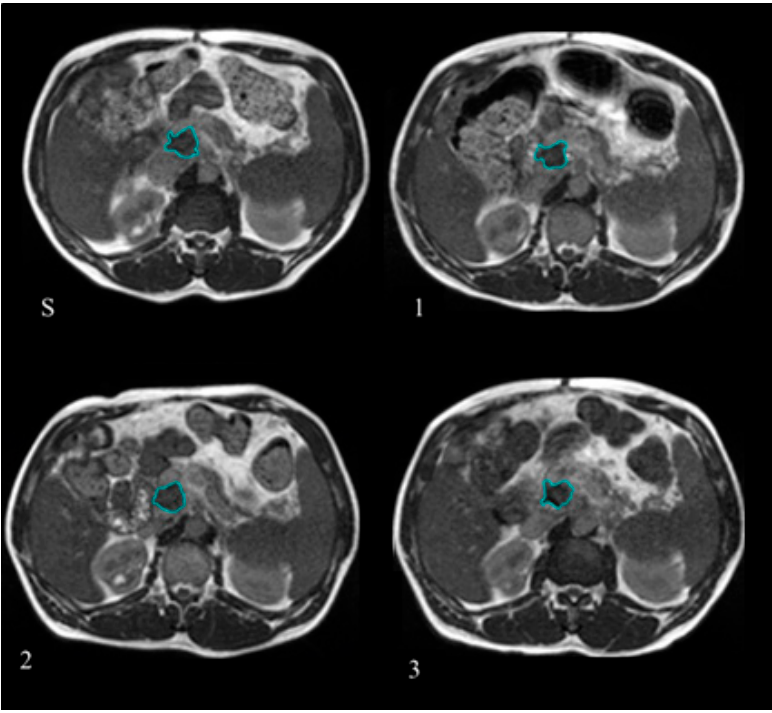
Figure 1. Gross tumour volume (GTV) delineated at the treatment simulation ( S ) and at the different treatment fractions selected for the Delta Radiomics analysis, corresponding to BED levels of 20 Gy ( 1 ), 40 Gy ( 2 ), and 60 Gy ( 3 ). The GTV contours are reported in blue lines